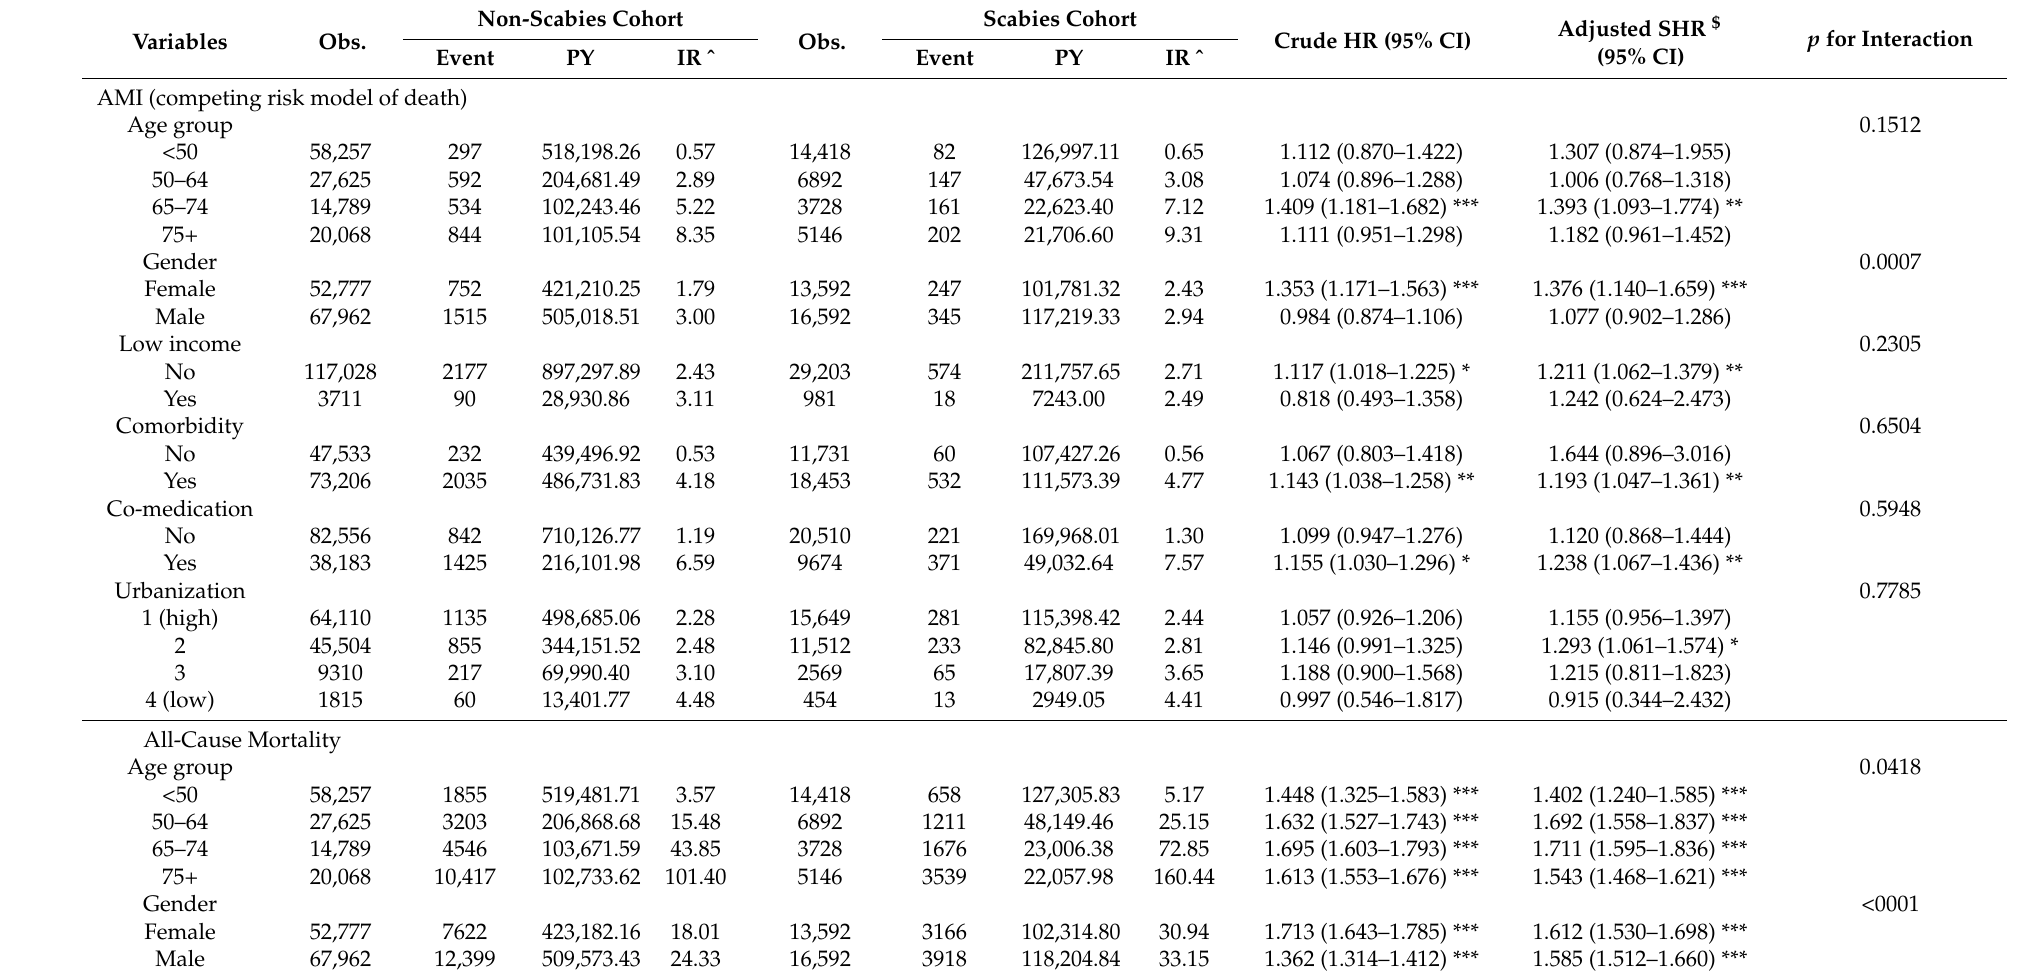
Table 4. HRs and 95% CIs of AMI and all-cause mortality stratified by age, gender, low income, co-morbidity, co-medication, and